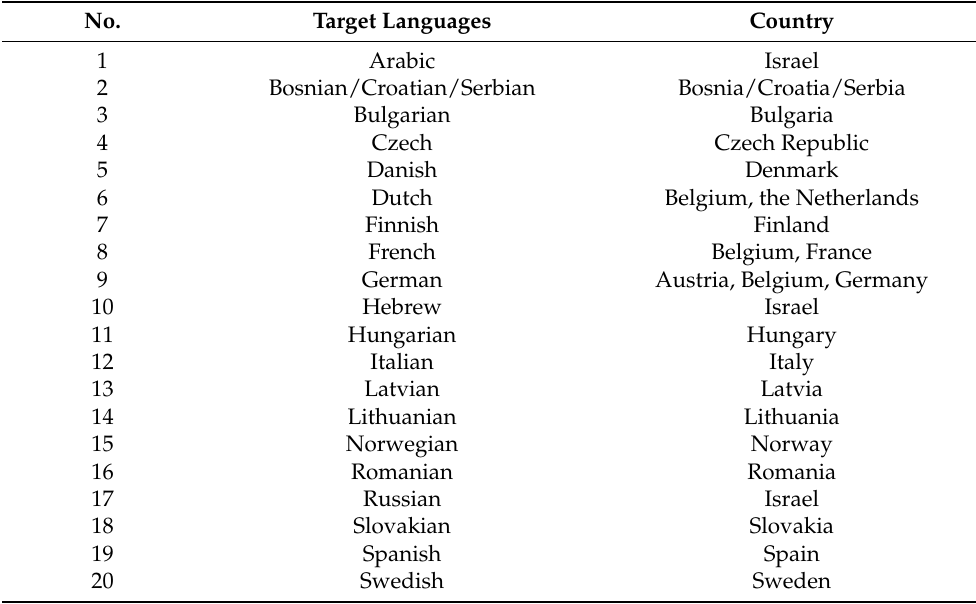
Table 1. Target languages for the linguistic validation of the countries that participated in the CENTER-TBI